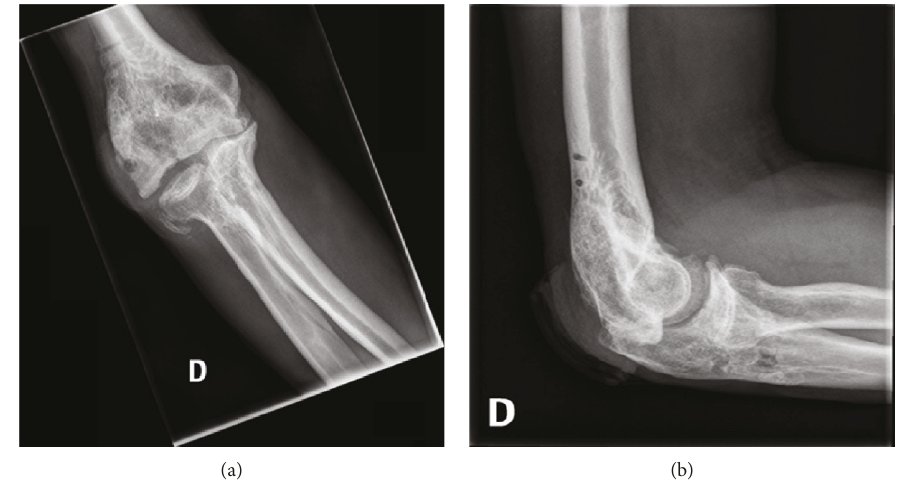
Figure 4: (a) Anteroposterior and (b) lateral 11 months postoperative X-rays of the right